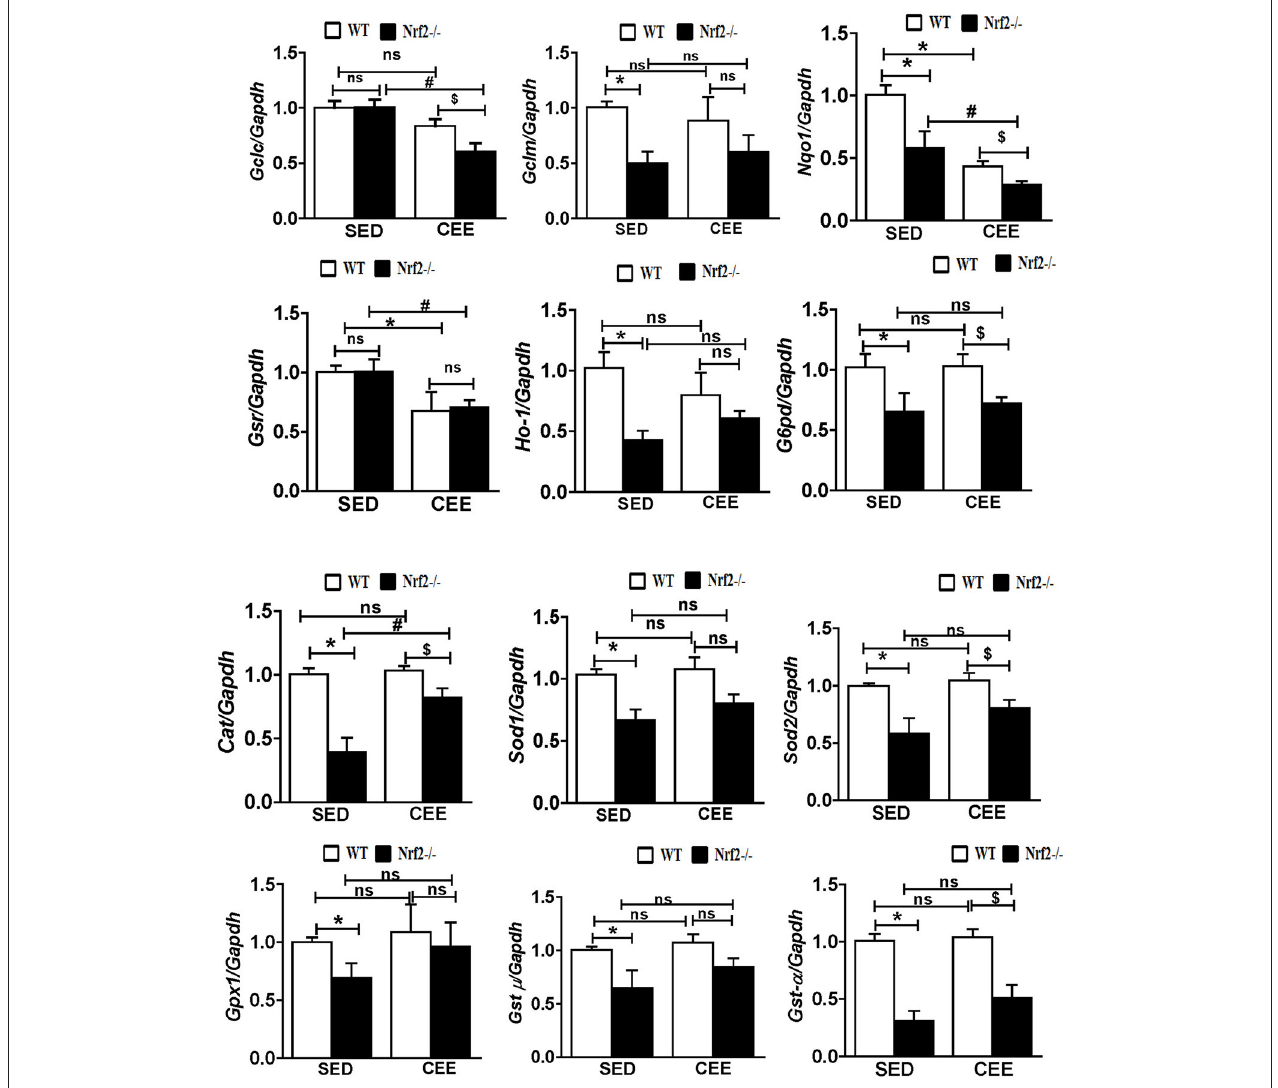
FIGURE 1 | Disruption of the antioxidant system upon chronic endurance exercise in aged Nrf2 − / − mice hearts. mRNA expression of Gclc, Gclm, Nqo1, Gsr, Ho-1, G6pd, Cat, Sod1, Sod2, Gpx1, Gst- µ , and Gst- α were determined in WT and Nrf2 − / − mice hearts by RT-qPCR. Gene expression was calculated by normalizing the Ct values with the housekeeping gene Gapdh/Arbp1. N = 4–6/ group. Results are expressed as mean ± SD and different symbols above the bars indicate statistically different mean values with the corresponding groups as assessed by one way ANOVA followed by Tukey multiple comparison tests (* P < 0.05 vs. WT-SED, # P < 0.05 vs. Nrf2 − / − -SED, $ P < 0.05 vs. WT CEE).